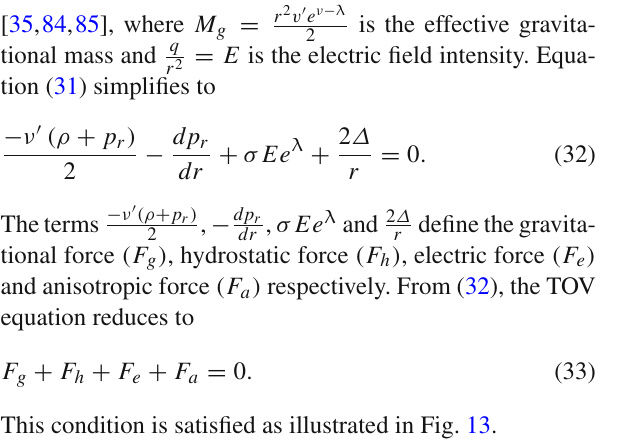
Fig. 14 Surface red shift z s against radial distance